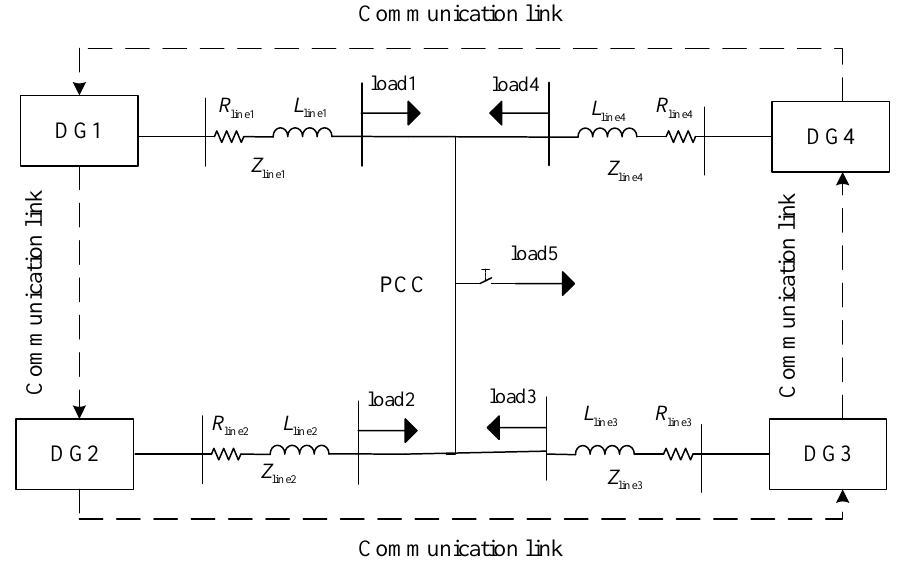
Figure 11. Case study of the microgrid. Table 3. System parameters.